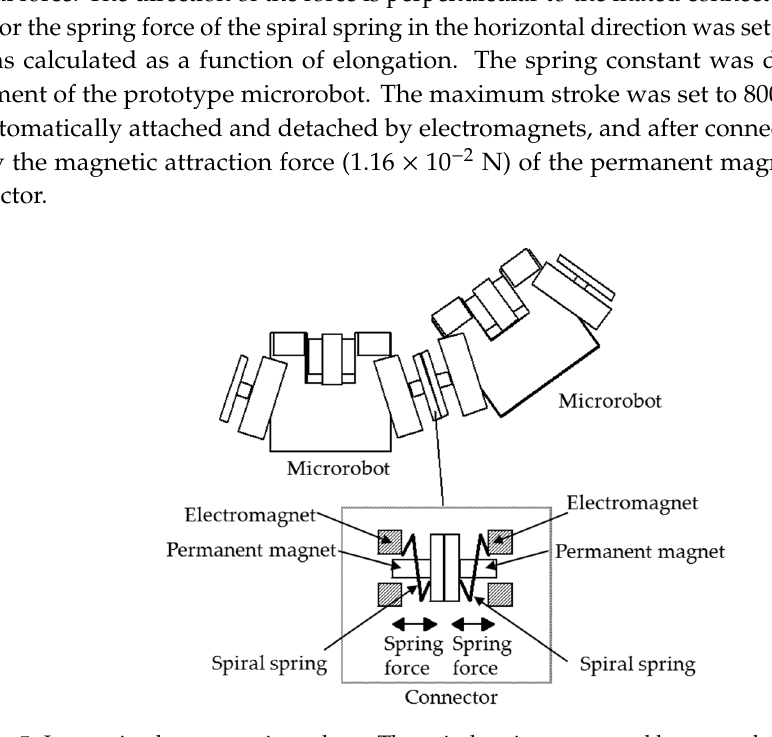
Figure 5. Interaction between microrobots. The spiral spring connected between the microrobot body and the connector device is extended compared to its natural length. The connector can be automatically attached and detached by electromagnets, and after connection, the connection is held by the magnetic attraction force of the permanent magnets arranged inside the connector.